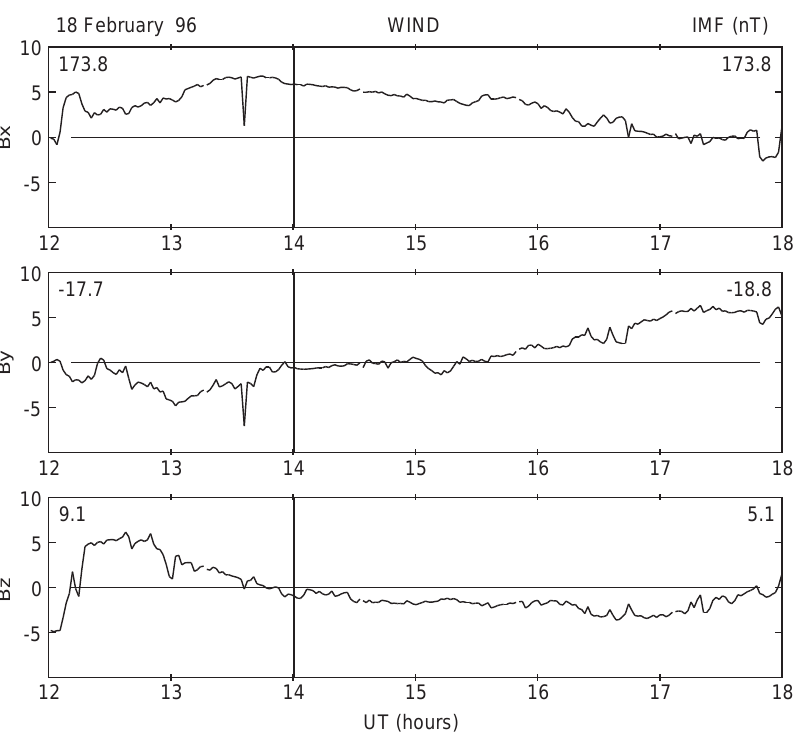
Fig. 2. Interplanetary magnetic field measured by the WIND satellite at 173.8 Earth radii, well in front of the magnetopause. All three IMF components are shown in GSM coordinates. Units for all three quantities